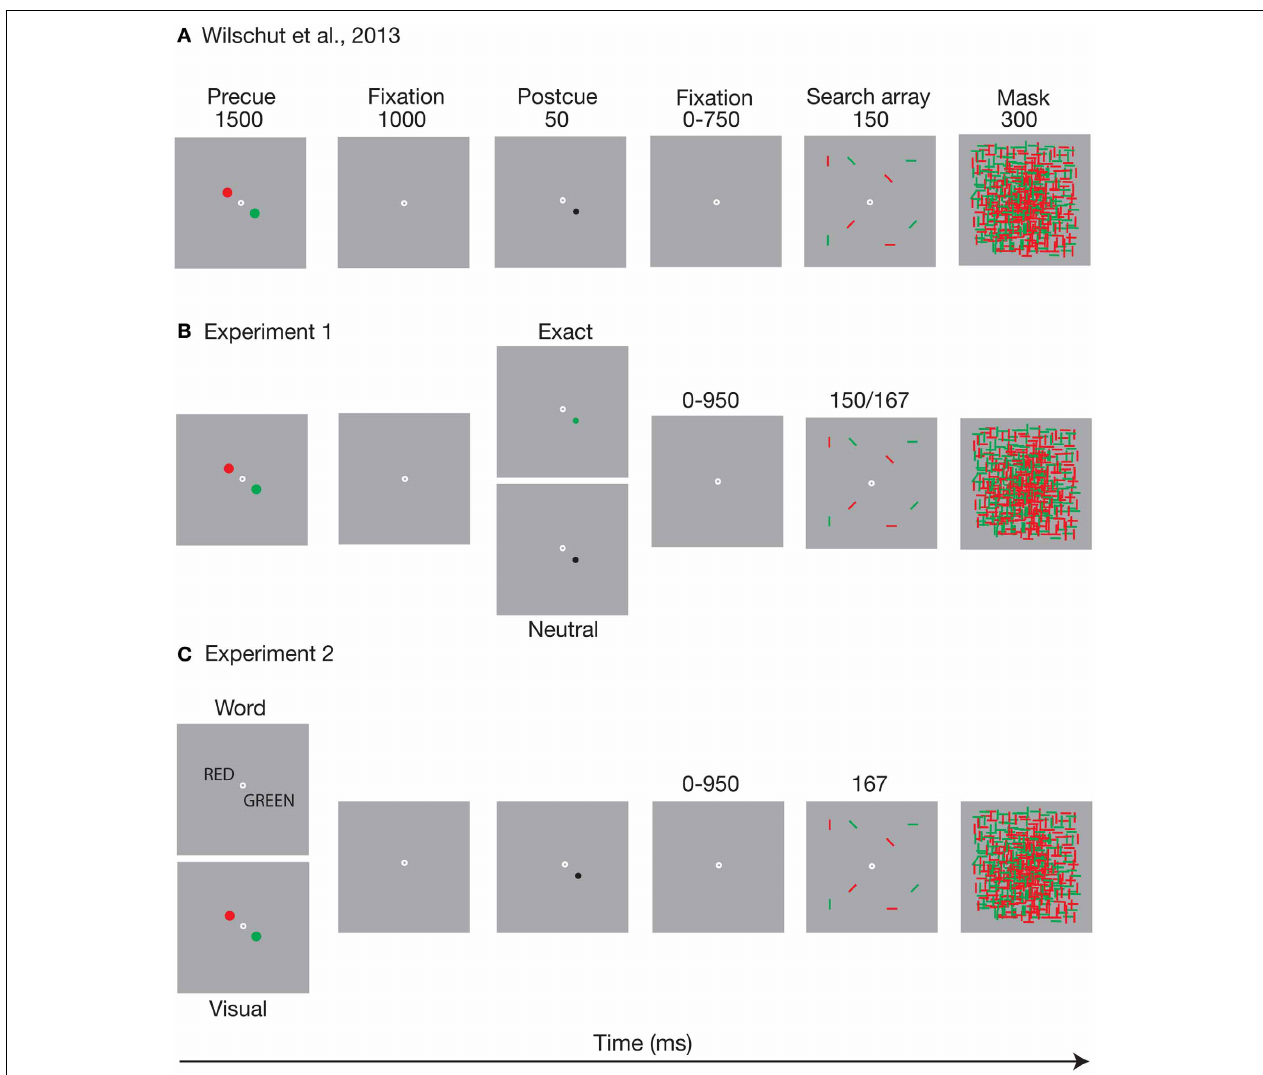
FIGURE 1 | The figure depicts an outline of the task of (A) Wilschut et al. (2013) as well as (B) the postcue manipulation, and (C) the precue manipulation of Experiments 1, 2 of the present study, respectively. (A)